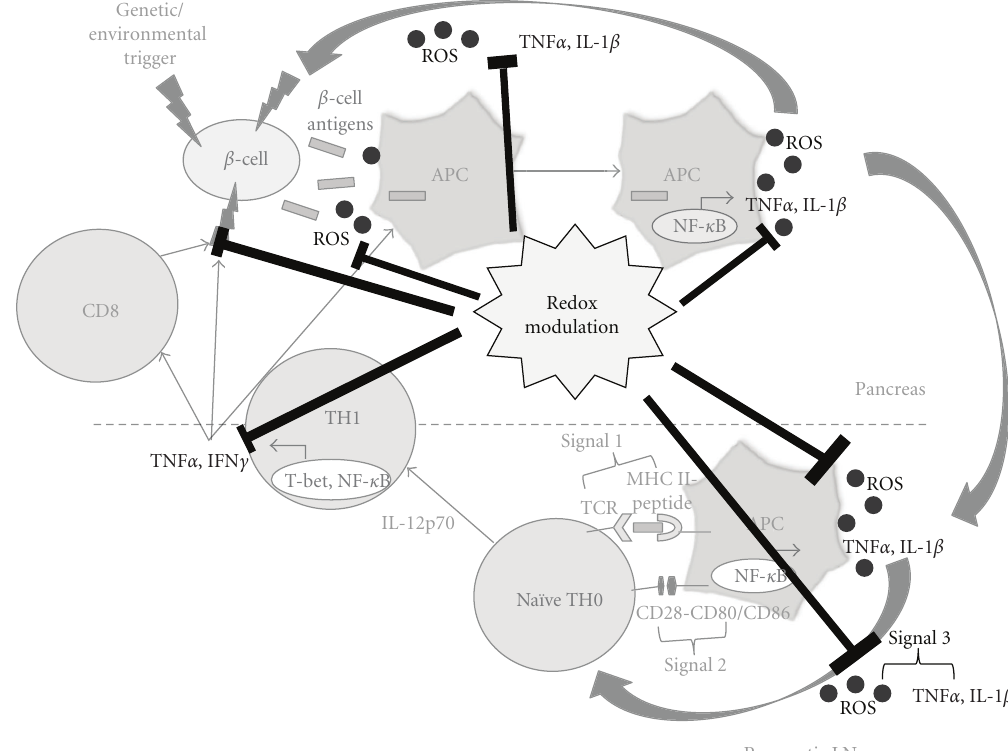
Figure 2: Role of redox modulation in controlling ROS-mediated beta cell destruction . Redox modulation has shown promise in blocking the production of ROS and its ability to activate APCs, resulting in diminished TH1 cell activation and e ff ector function, which ultimately may help regulate beta-cell